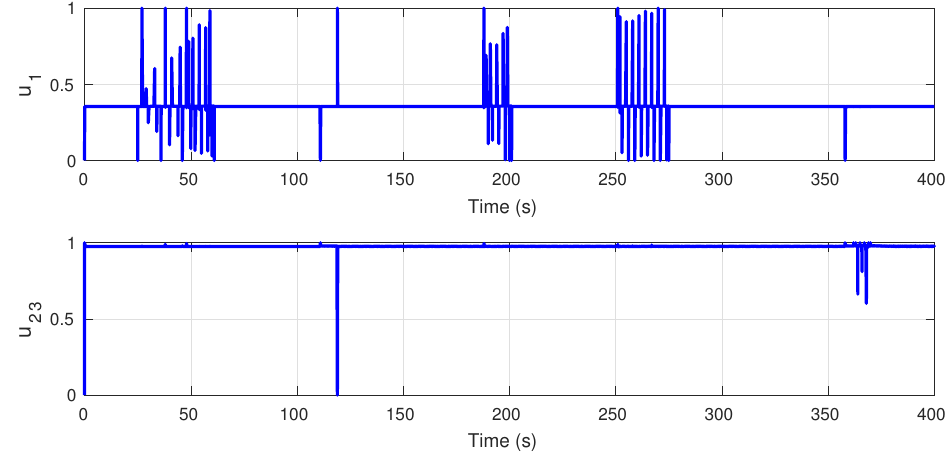
Figure 7. Time responses of inputs for the Lyapunov-based adaptive